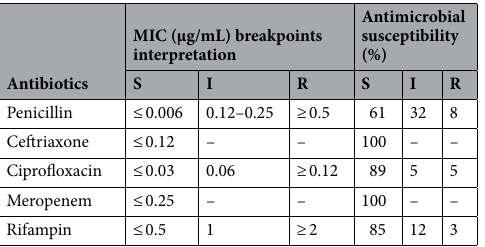
Table 1. Antimicrobial susceptibility testing for Neisseria meningitidis